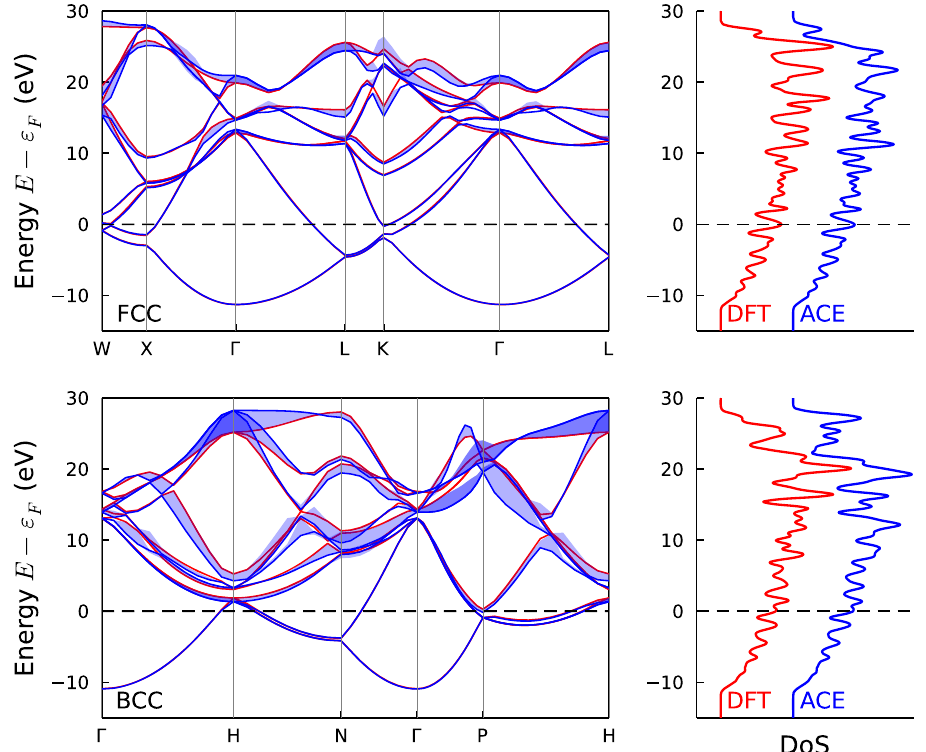
Fig. 5 FCC and BCC band structures obtained with DFT (red) and predicted by an ACE model with onsite H order 2, and offsite H and S order 1 (blue). Con fi dence intervals shown with blue ribbons are from a priori analysis of the errors in band spectrum expected to result from known errors in ~ H and ~ S (see text). Energies are shown relative to the DFT Fermi